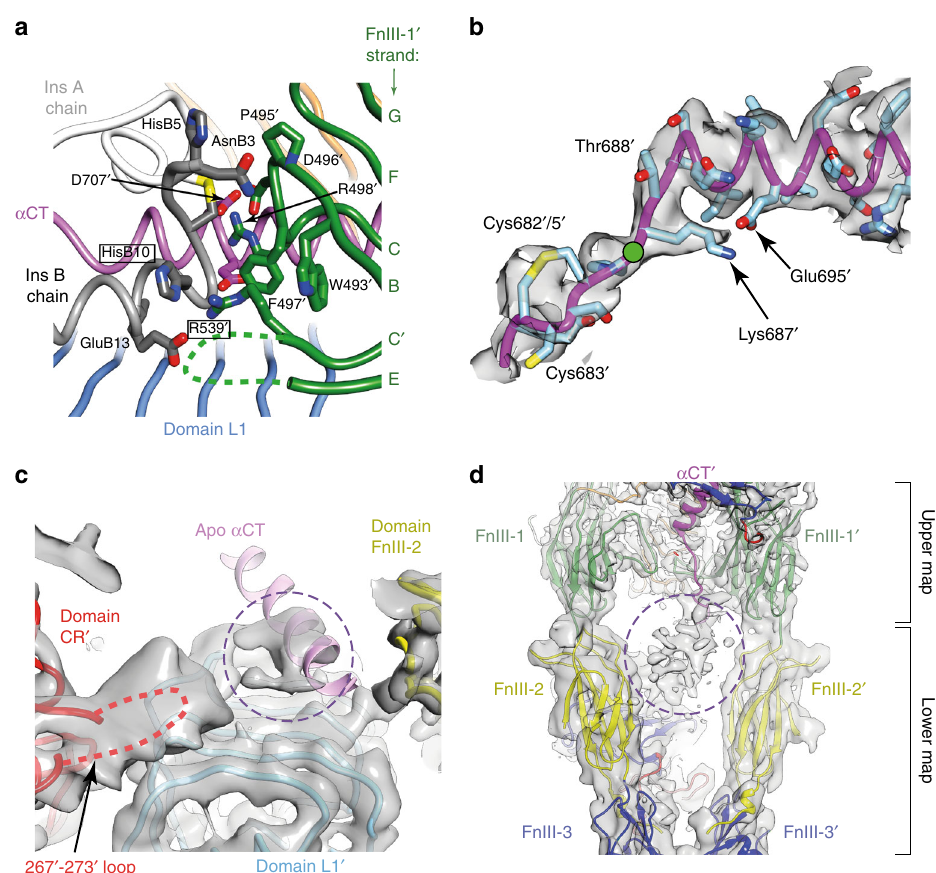
Fig. 3 Detail of the cryo-EM structure of IR Δβ -zipInsFv. a Interaction of insulin with FnIII-1 ′ , showing in particular the interaction of IR Arg539 ′ with insulin HisB10 (boxed residue labels). The dashed green line represents the poorly ordered segment between residues Ser541 ′ and Ser545 ′ . b N-terminal region of the α CT ′ helix showing termination of the helix at Asp689 ′ and the formation of a possible salt bridge between Lys687 ′ and Glu695 ′ , as well as a possible conformation for the Cys 682 ′ :Cys683 ′ :Cys685 ′ triplet. Density shown is from the upper map. The green circle indicates the effective location of the four- glycine insert in the 686G4 mutant receptor and receptor ectodomain (see main text). c Density extracted from the lower map in the vicinity of the insulin- free domain L1, showing the density feature on the central β sheet of the domain (circled) and the overhanging CR ′ domain loop containing residues Lys267 ′ to Gly273 ′ (dashed red line). The relative location of the α CT helix in the crystal structure of apo IR Δβ is shown for reference and is not included in the atomic model of IR Δβ -zipInsFv. d Density features (circled) associated with the unmodelled and partially disordered segments of ID and ID ′ . Density shown is extracted from both the upper and lower maps (as indicated on the right of the